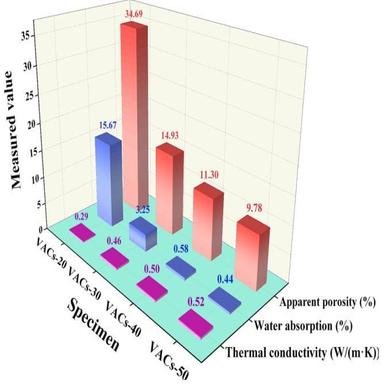
Water absorption, apparent porosity and thermal conductivity of sintered VACs specimens.